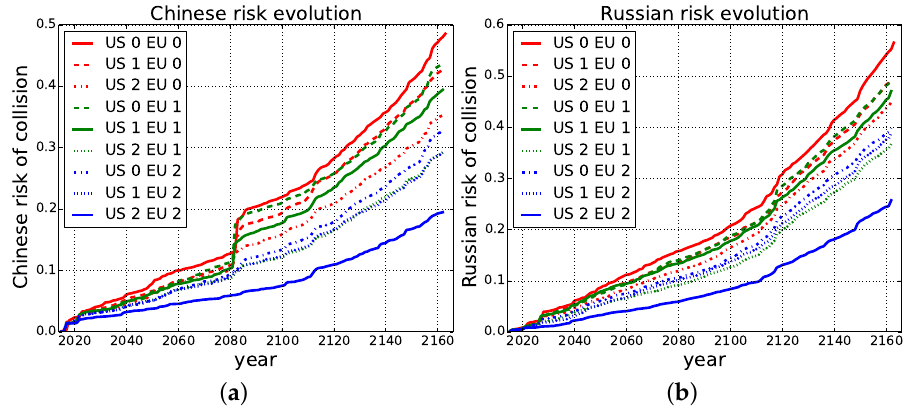
Figure 6. Free-riding effect in the overall risk to important assets for non-active players China and Russia, for combinations of actions of both the U.S. and EU. ( a ) Risk to Chinese assets; ( b ) risk to Russian assets.